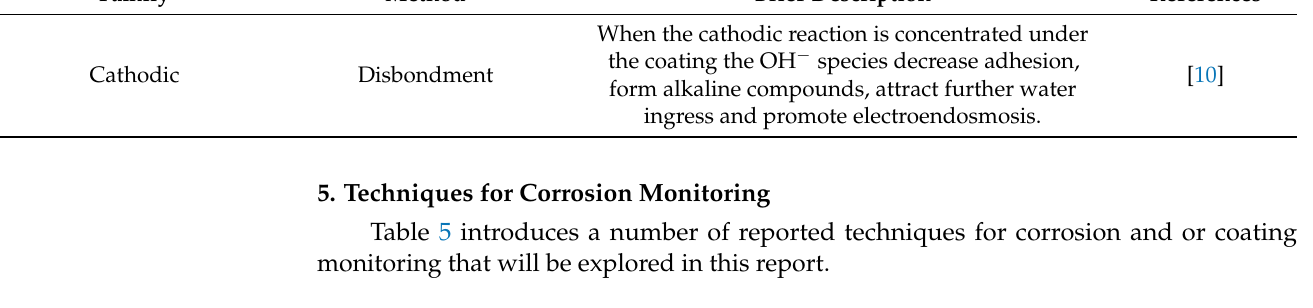
Table 5. Current techniques for corrosion and or coating